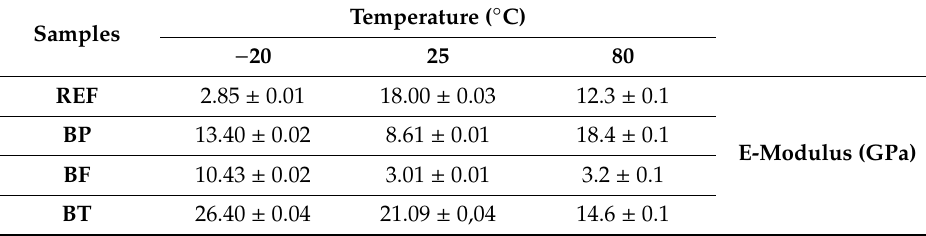
Table A2. Appendix A contains details and data supplemental to Figure